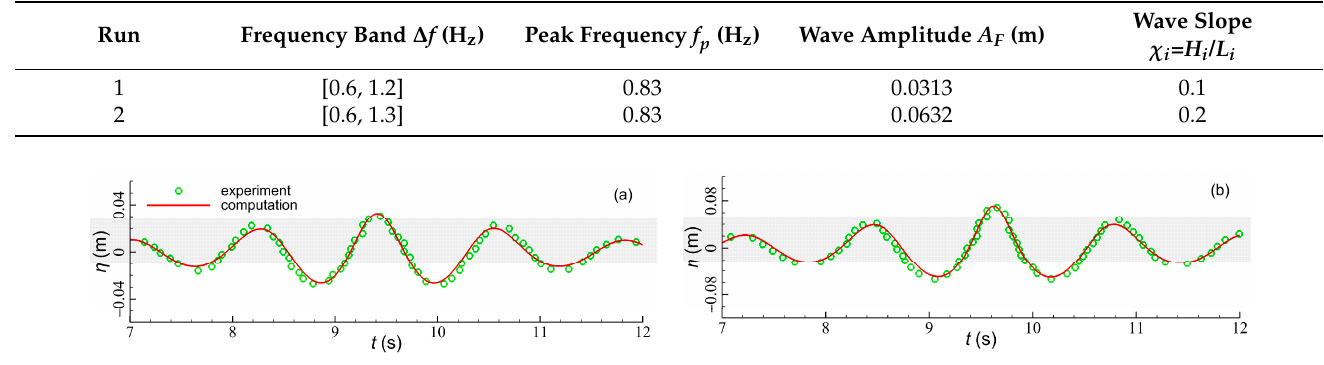
Figure 1. Comparison of the temporal evolutions of water surface elevations recorded at the actual focusing location: ( a ) run 1 and ( b ) run 2.